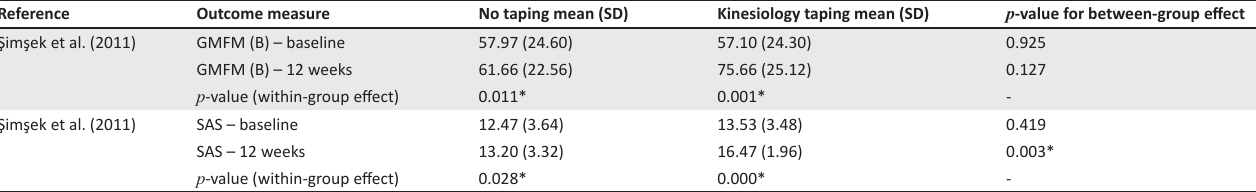
TABLE 6: Effect of kinesiology taping on sitting function as determined by Gross Motor Function Measure (B) and Sitting Assessment Scale. Reference